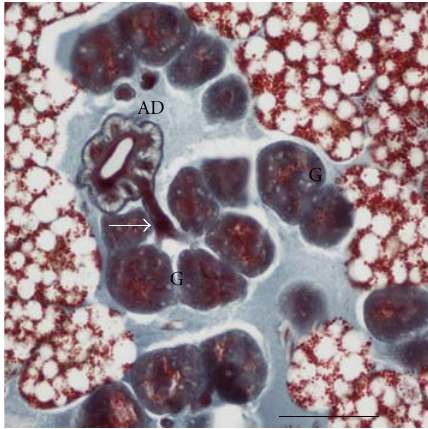
Figure 21: Tubule (arrow) connecting gland cells (G) to the ante- rior duct (AD) of a N. abietis larval salivary gland. Scale bar = 0.1mm.